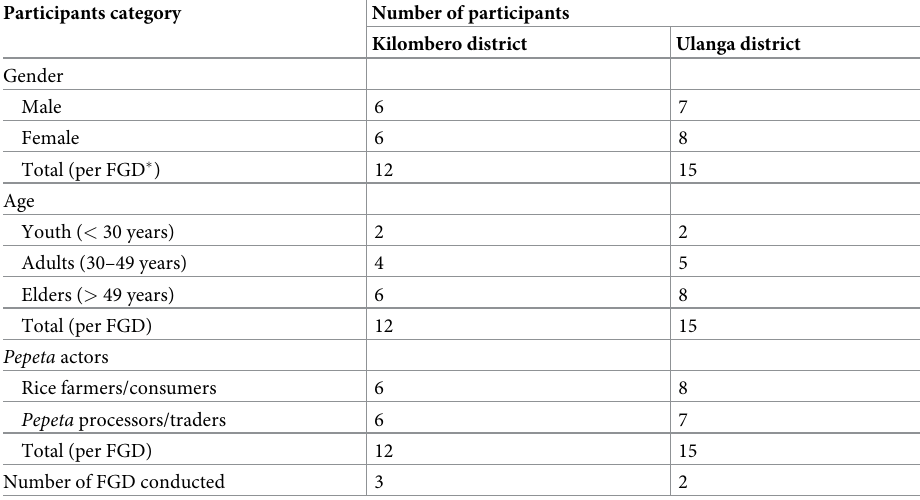
Table 3. Overview of focus group